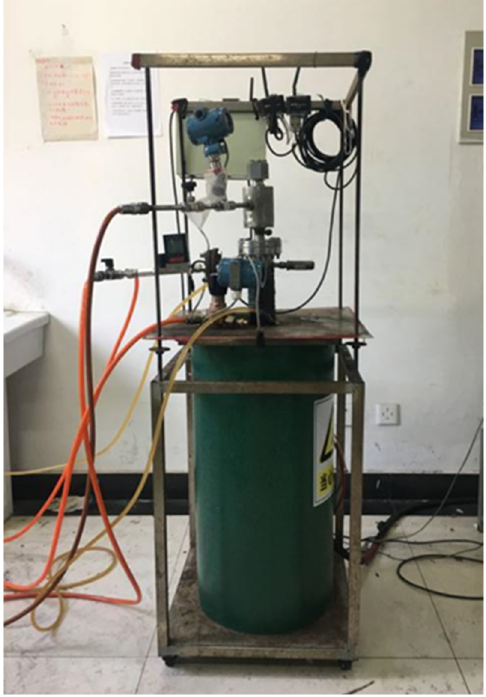
Figure 2. Experimental equipment.